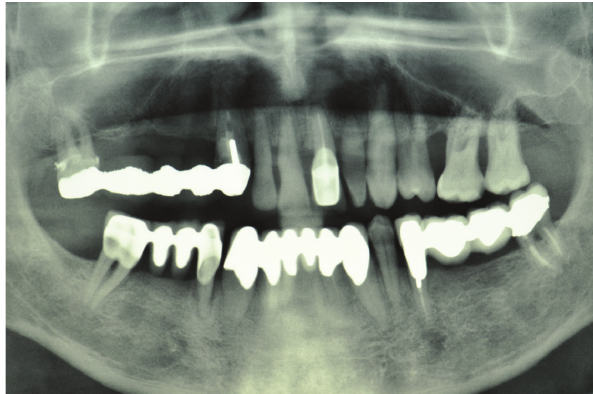
Figure 1: Case 1: Initial panoramic radiograph